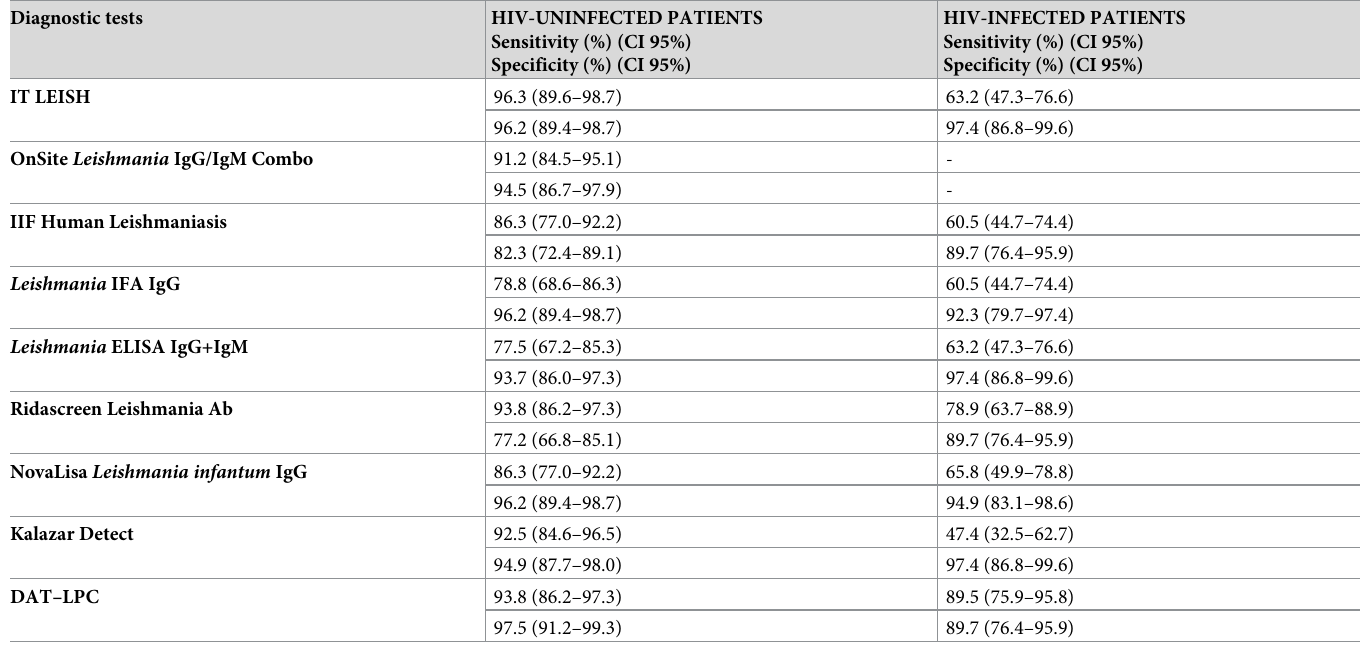
Table 2. Performance of the diagnostic tests stratified according to HIV status based on a previous study. Diagnostic